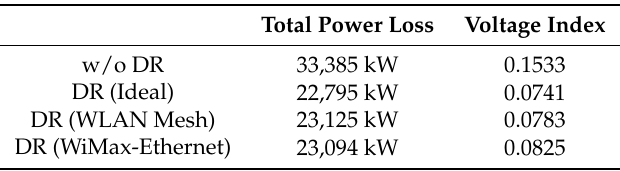
Table 2. The power loss and the voltage of 13 Node